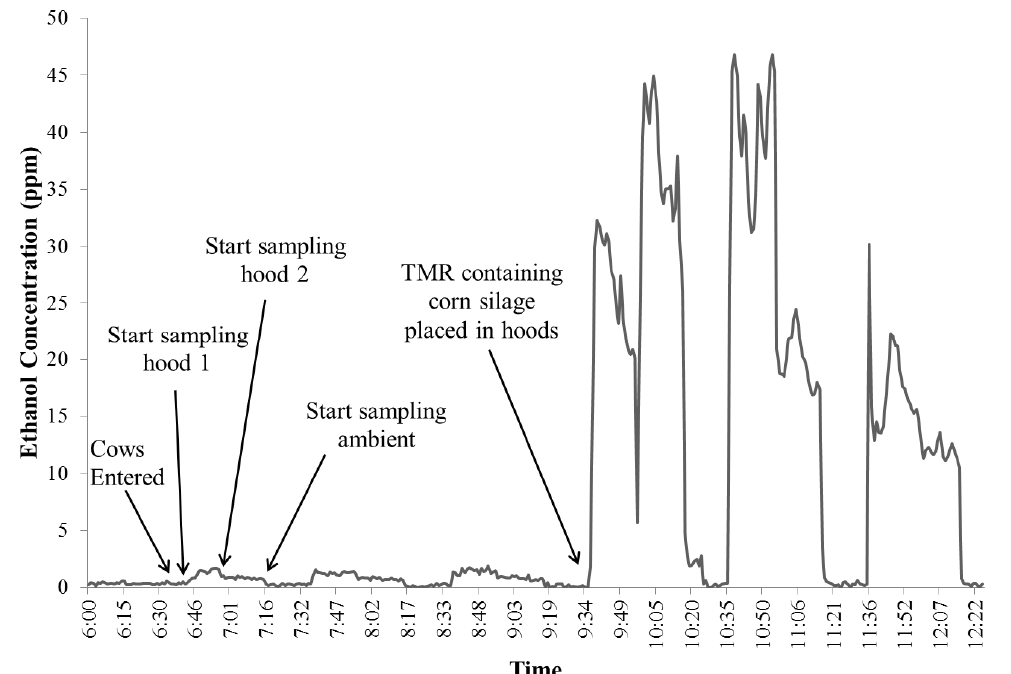
Figure 11. Example of raw ethanol concentrations (ppm) over time from the INNOVA